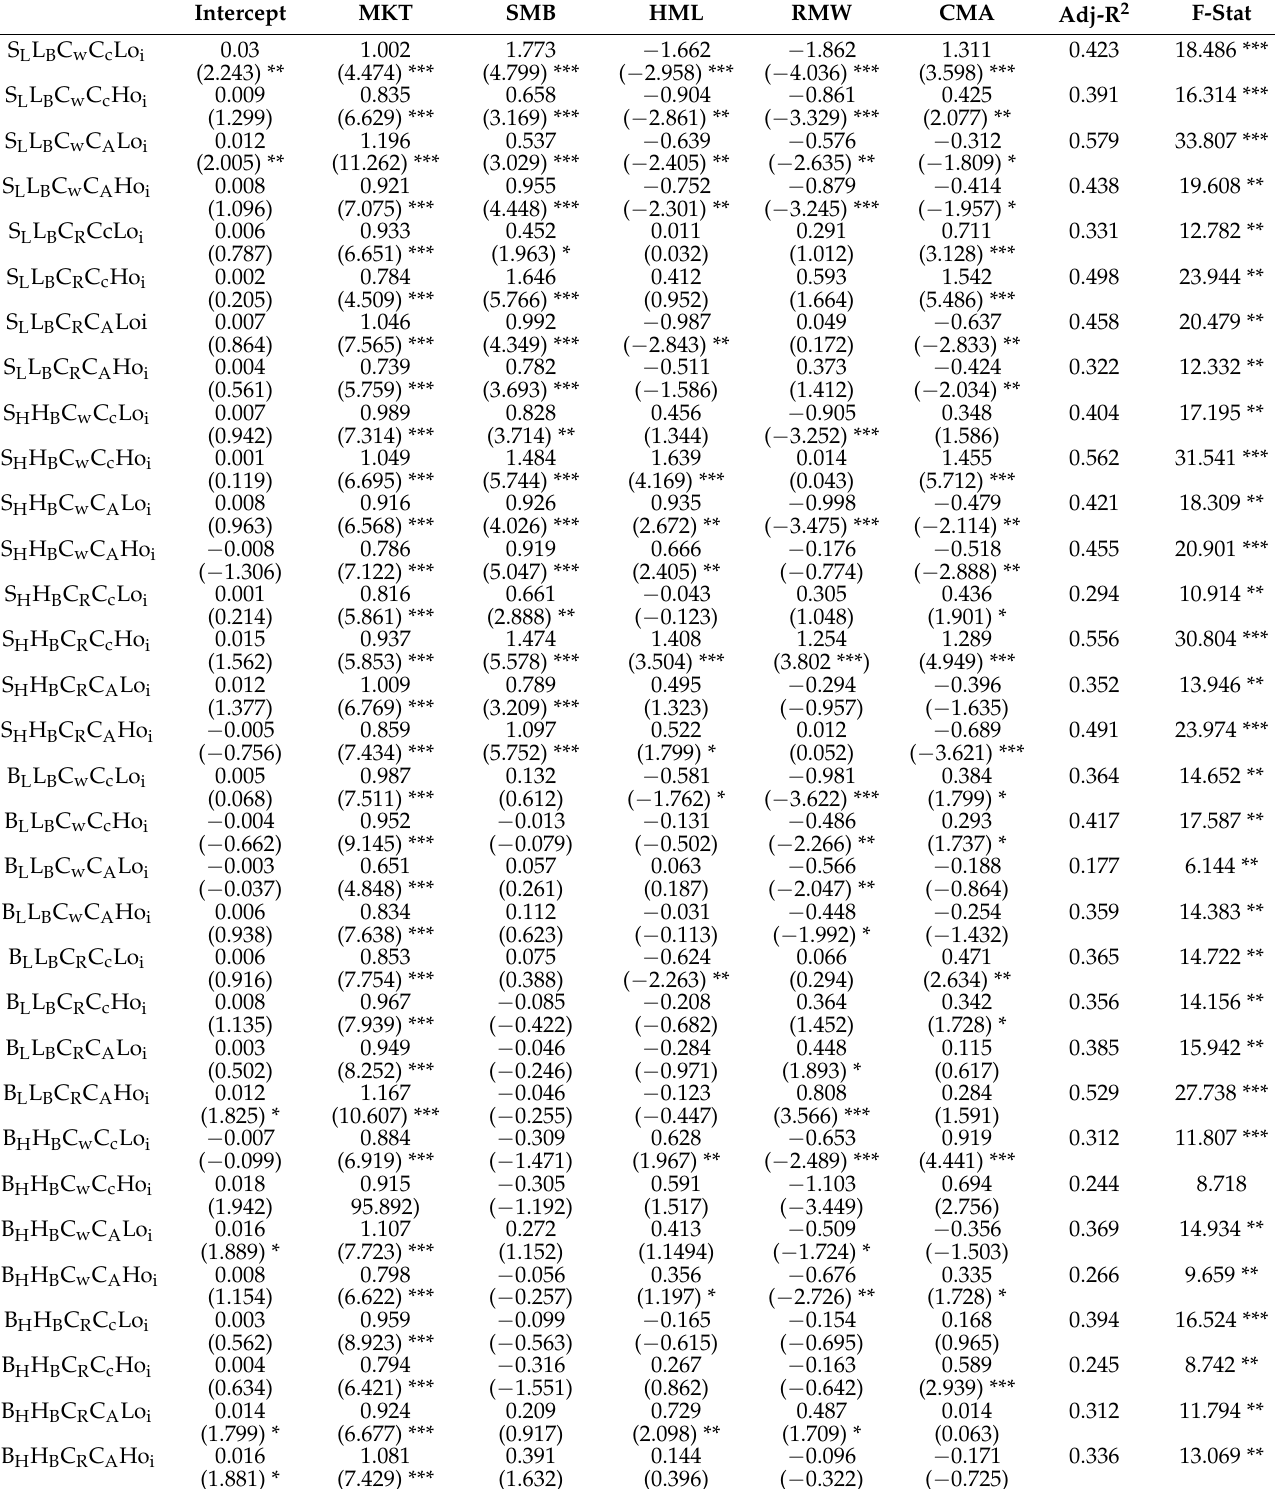
Table 8. Fama–French Five-Factor